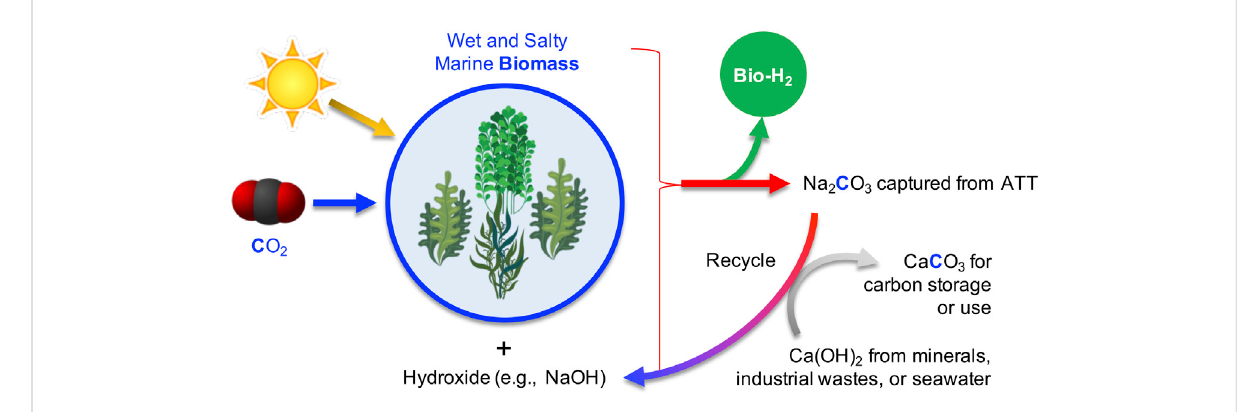
FIGURE 4 Alkaline thermal pretreatment (ATT) of marine biomass for carbon